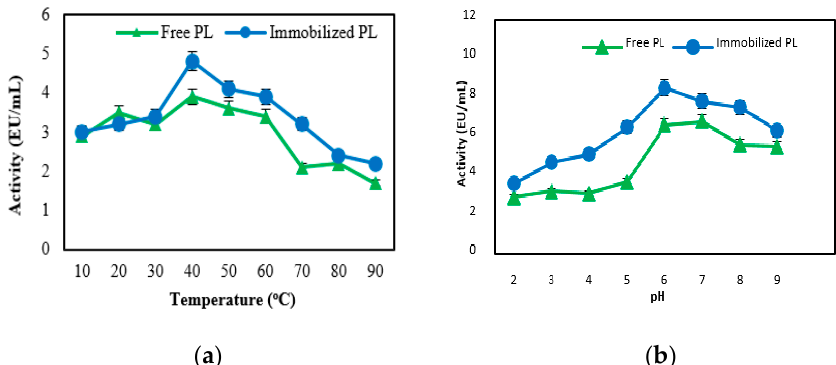
Figure 2. The effect of temperature ( a ) and pH ( b ) on activities of free and immobilized pectin lyase enzymes.